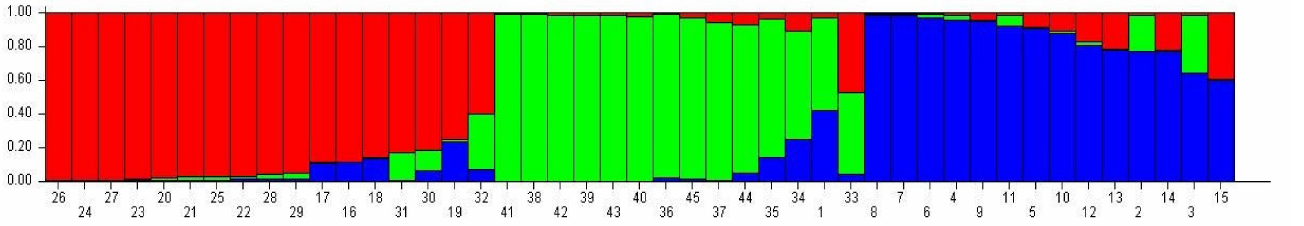
Figure 4. Graphic representation of population structure according to SSR data [For each bean genotype, subgroup 1 (red), subgroup 2 (green), and subgroup 3 (blue) are indicated by a vertical line representing the genotypes (K =